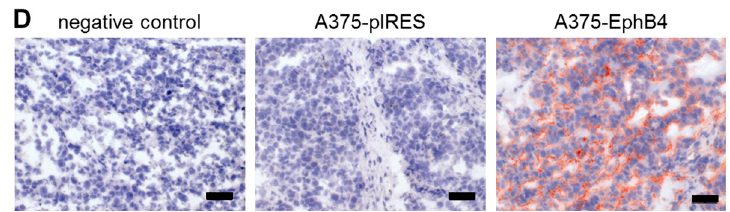
Figure 1. EphB4 expression in transfected A375 melanoma cells and corresponding tumor xenografts.